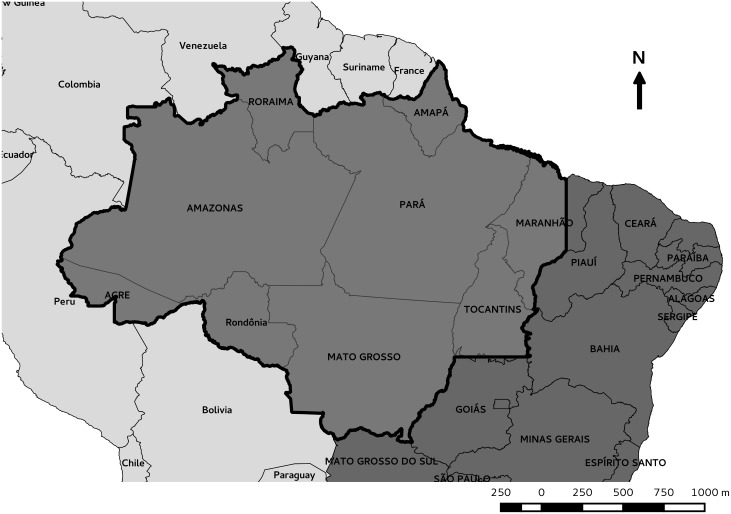
Brazilian Amazon.Brazilian Amazon (large boundary) with yours the state names, Brazil (dark gray) and South America with countrys names (light gray).